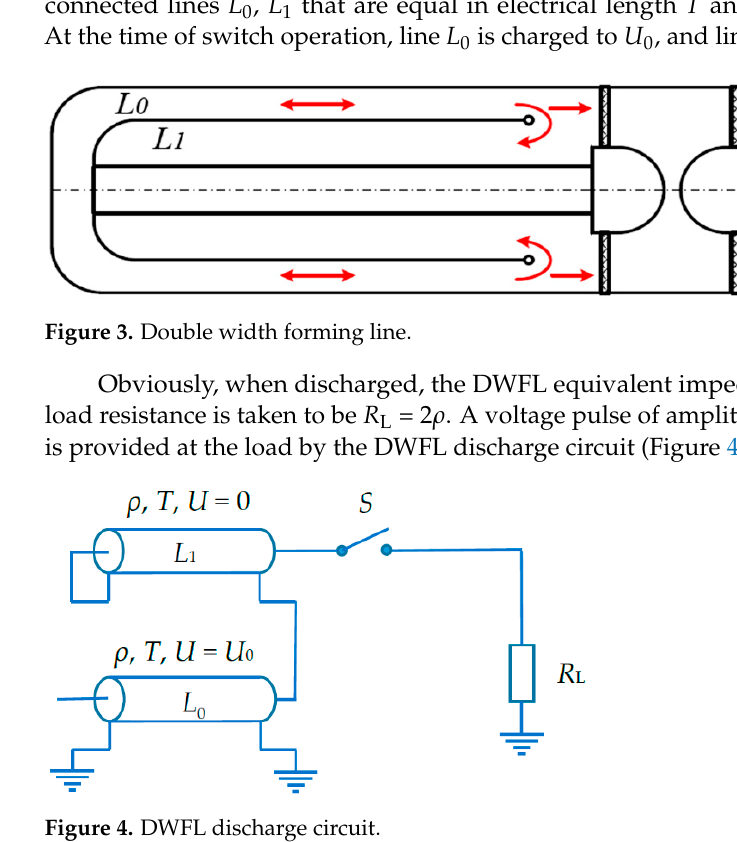
Figure 4. DWFL discharge circuit.